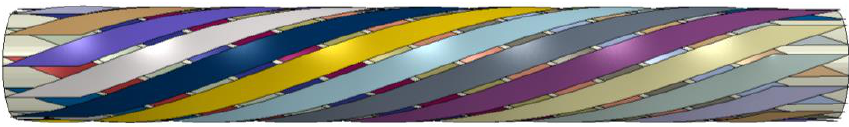
Figure 8. Topology diagram of double-layer CORC cable.